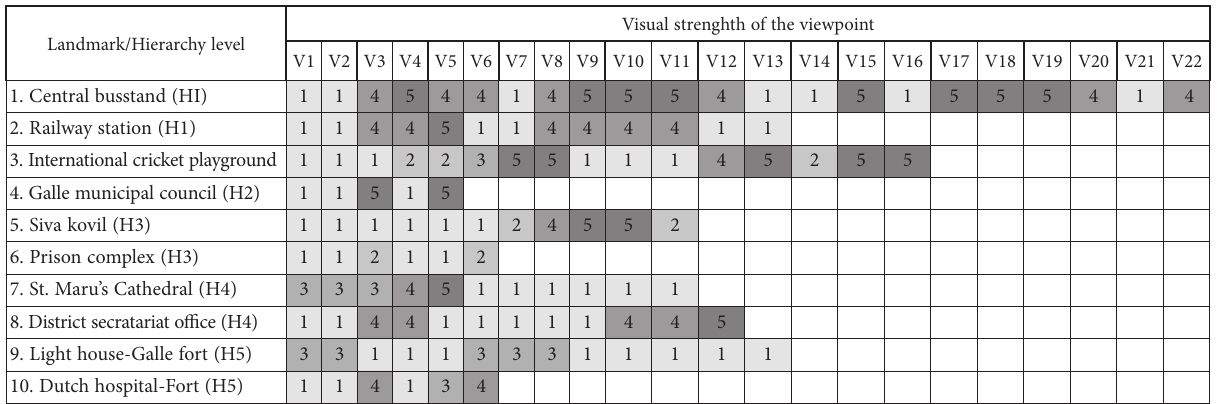
Visual strenghth of the